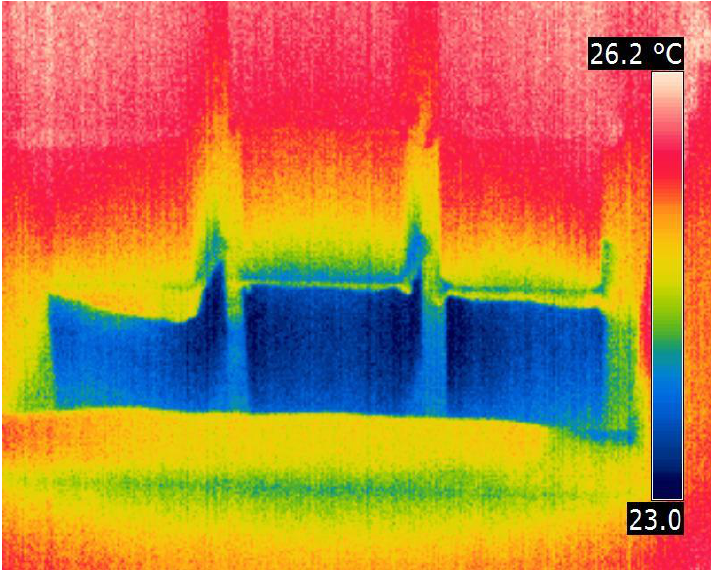
Figure 11. Thermographic report dated 14 September 2018 for carparo (C.), Lecce stone (L.S.), and tuff (T.).